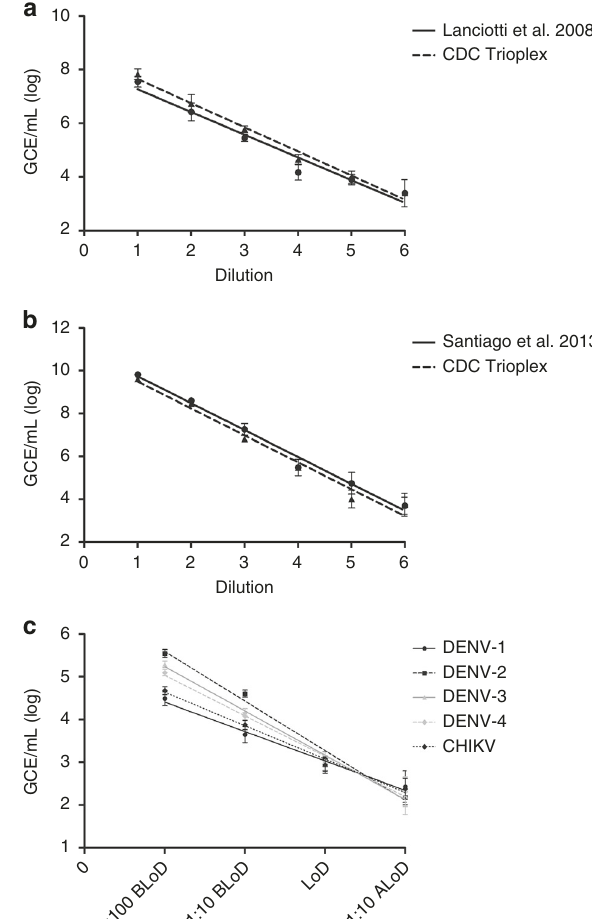
Fig. 1 Analytical performance of the Trioplex assay in multiplex format for all target viruses. Normal human serum was spiked with Zika virus, dengue virus type 1 (DENV-1), dengue virus type 2 (DENV-2), dengue virus type 3 (DENV-3) or dengue virus type 4 (DENV-4). Six serial dilutions (1:10) were tested to compare ZIKV detection performance of the Trioplex assay with the CDC ZIKV reference assay 18 ( a ) or DENV detection with the CDC DENV reference assay 29 ( b ). Data for DENV-4 is shown. Straight line represents linear regression of CDC reference test. Dashed line represents linear regression for Trioplex assay. Trioplex assay limit of detection evaluated for each DENV serotype and chikungunya virus testing 20 replicates per dilutions: 1:100 before LoD (BLoD), 1:10 before LoD (BLoD), LoD and 1:10 after LoD (ALoD) ( c ). Mean genome copy equivalents per milliliter (GCE/mL) of viral RNA are displayed at each dilution. Error bars represent GCE/mL standard